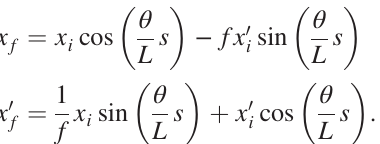
FIG. 19. Generated mismatches along the bunch with respect to the central slice of the beam assumed as input distributions in the simulations. The large-mismatch beam (similar to the measure- ment shown in Fig. 17) is obtained by the rotation of the horizontal transverse phase space of the small-mismatch beam (corresponding to the measurement shown in Fig. 7).